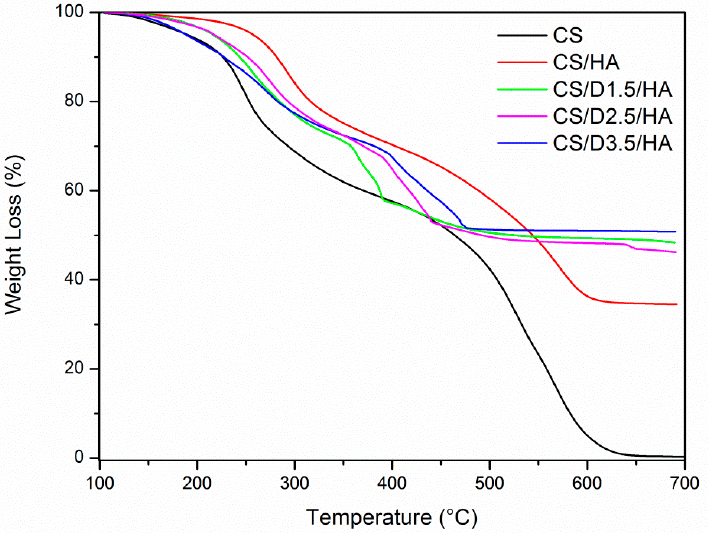
Figure 4. TGA curves for CS, CS-HA and CS-D-HA hydrogels. All experiments were performed under air atmosphere .